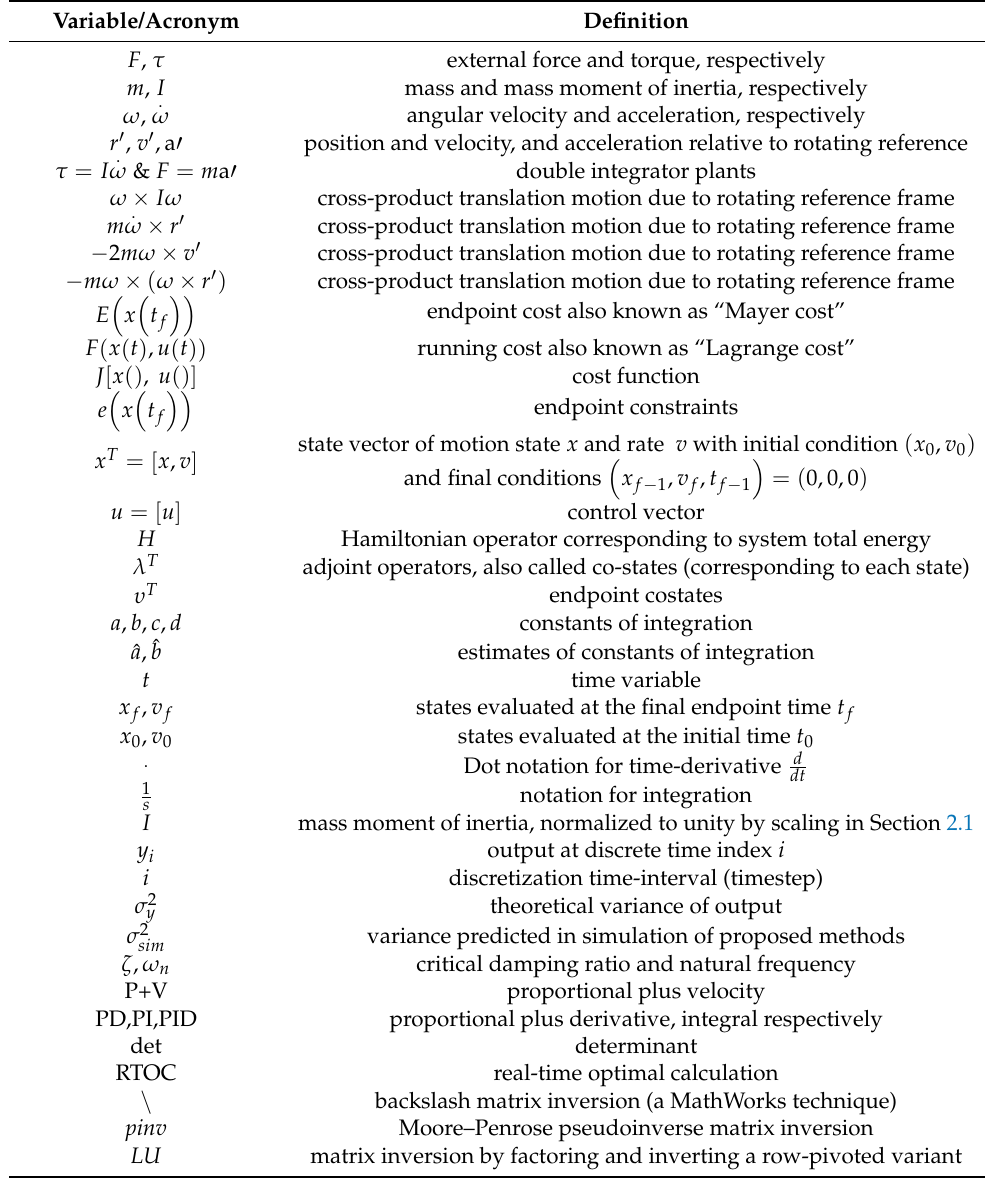
Table A1. Variables and